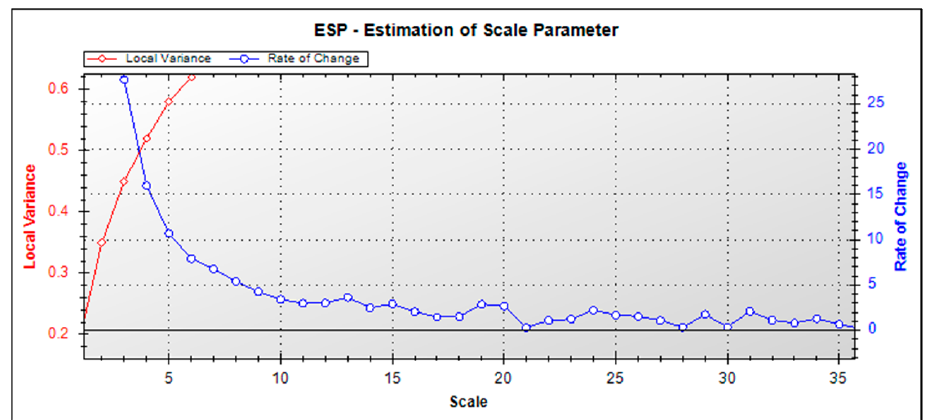
Figure 3. Rate of change of local variance (ROC-LV) curve of multiresolution segmentation of Zhongye Island images.